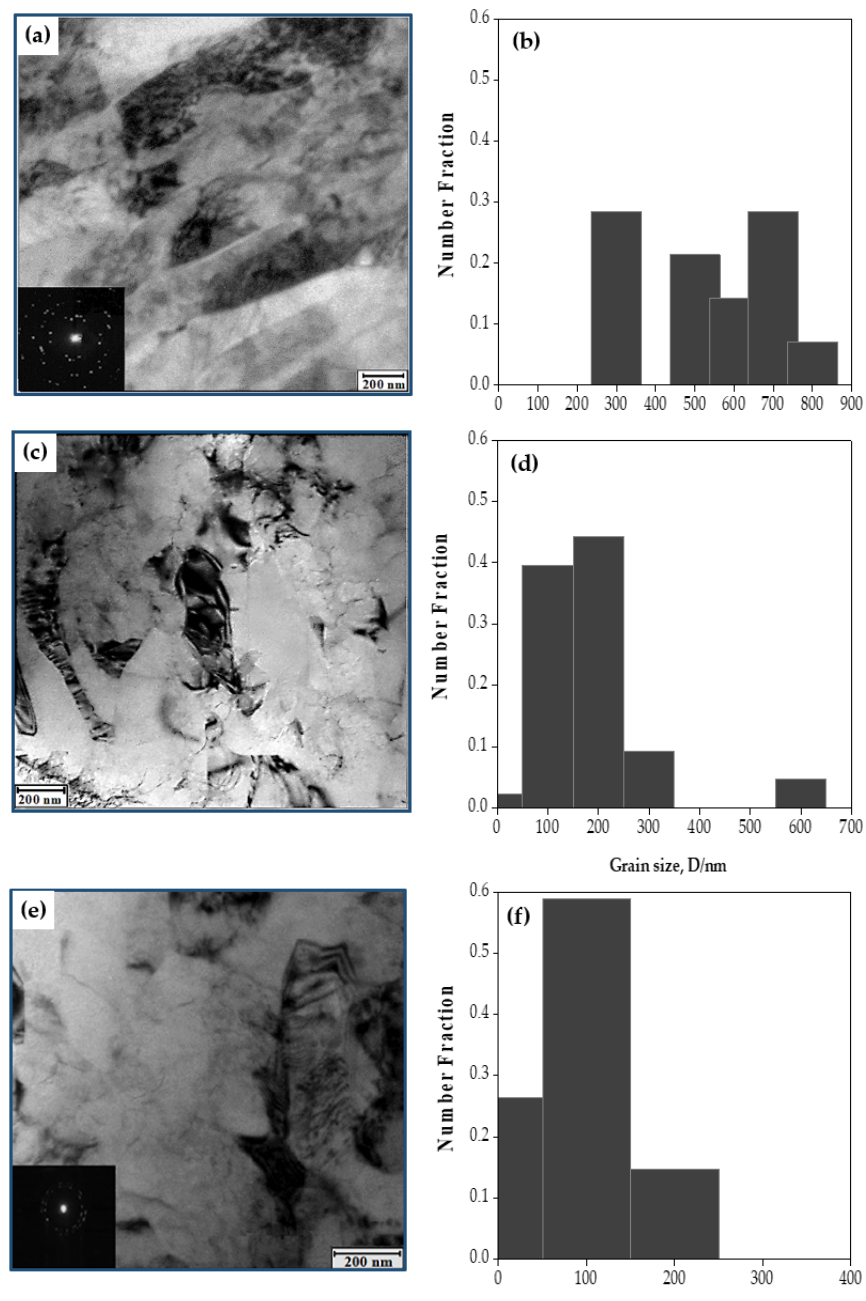
Figure 4. TEM photomicrographs of the microstructure and the corresponding grain-size distribution of copper tubes processed in ( a , b ) 1 pass, ( c , d ) 2 passes, and ( e , f ) 4 passes. samples was near the average grain size in each case (Figure 4b,d,f). The increase in the imposed strain from 2.5 up to 10 after one and four passes is effective in the evolution of the grains from elongated to equiaxed ultrafine grain (UFG) microstructure. Moreover, increasing the strain was influential in the evolution of the grain boundaries into high misorientation angle grain boundaries (HAGBs), as noted by the SAED pattern (Figure 4e). The SAED pattern of the PTCAP Cu tube processed to 4 passes, as shown in Figure 4e, indicates a pattern that consists of rings with constant intensity and many diffracted